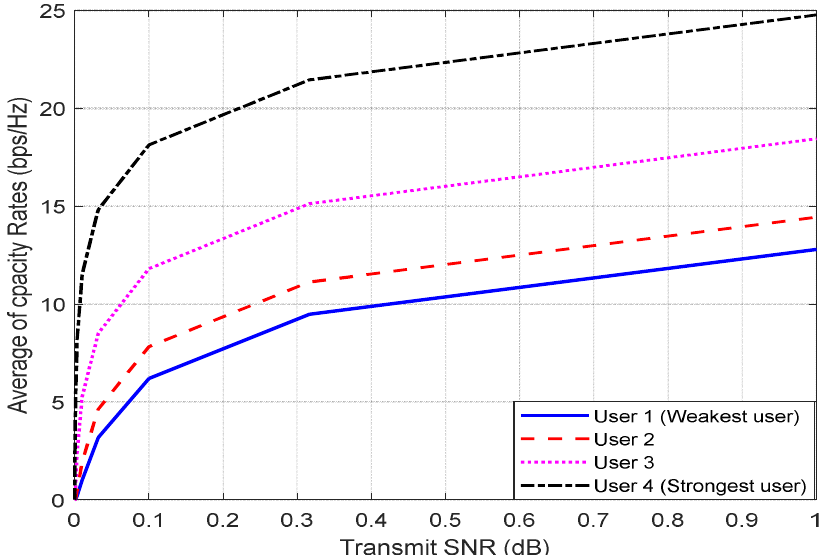
Figure 13. Average capacity rate vs. SNR for four users with varying distances, with 64 × 64 MIMO and BW 80 MHz for UL NOMA.